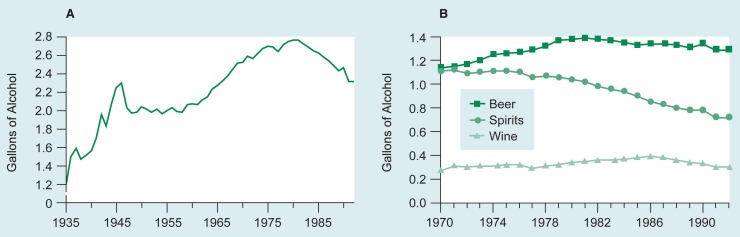
Apparent per capita alcohol consumption statistics calculated from beverage sales data from the 50 States and the District of Columbia. These statistics reveal the average number of gallons of alcohol consumed by a person in the United States. Graph A shows total per capita alcohol consumption in the United States from 1935 to 1992. Graph B shows per capita alcohol consumption by beverage type in the United States from 1970 to 1992.SOURCES: Doernberg and Stinson 1985; Williams et al. 1994.